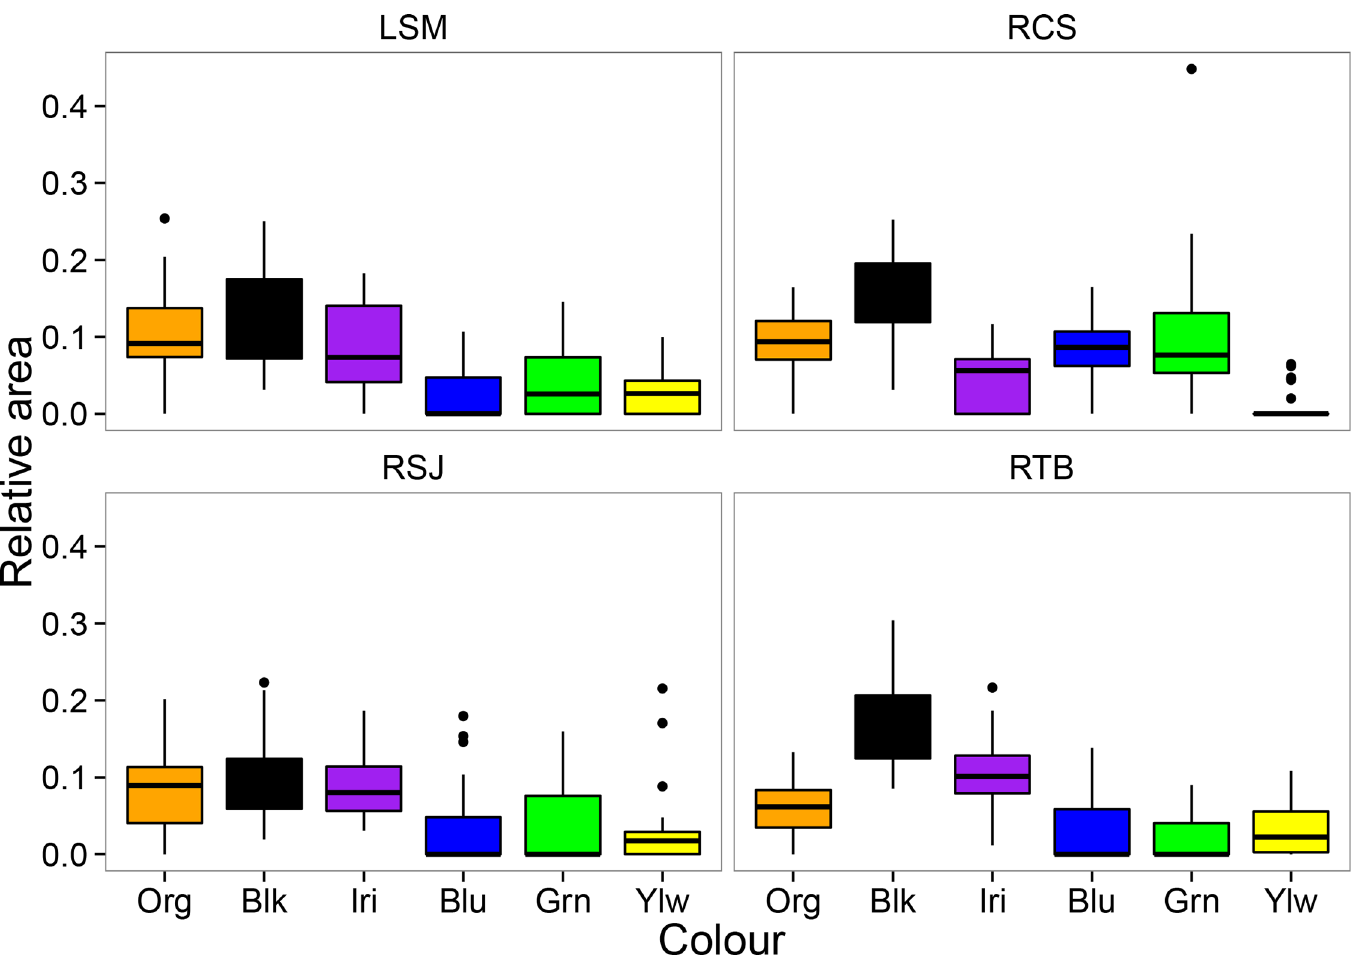
Fig 2. Relative area of different colour spots in introduced populations of P . reticulata in Panama. Boxes represent the interquartile range and the error bars represent the total range of the data. Site names and colour conventions are the same as in Fig 1.